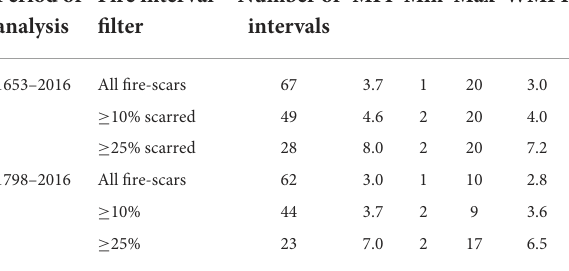
TABLE 1 Historical fire interval statistics for a Pinus lumholtzii forest, in the Sierra Madre Occidental, Durango, Mexico. Period of